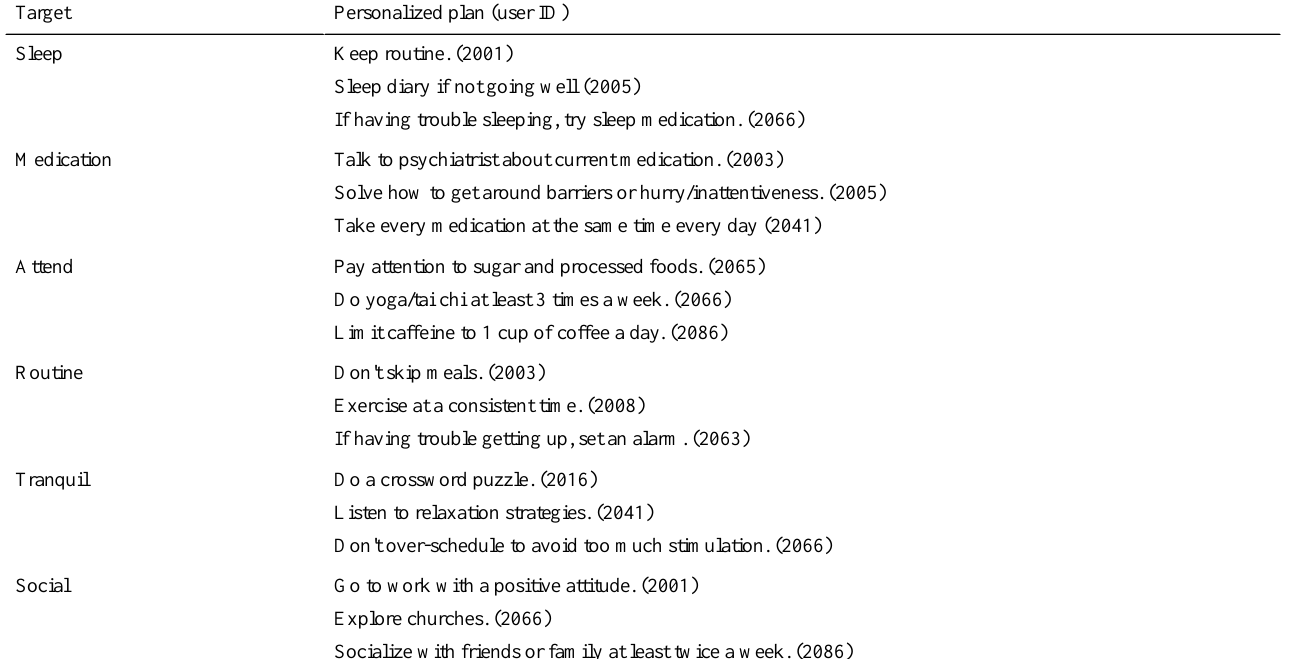
Table 4. Pilot study: lifestyle plan for reducing risk (n=11). Personalized plan (user